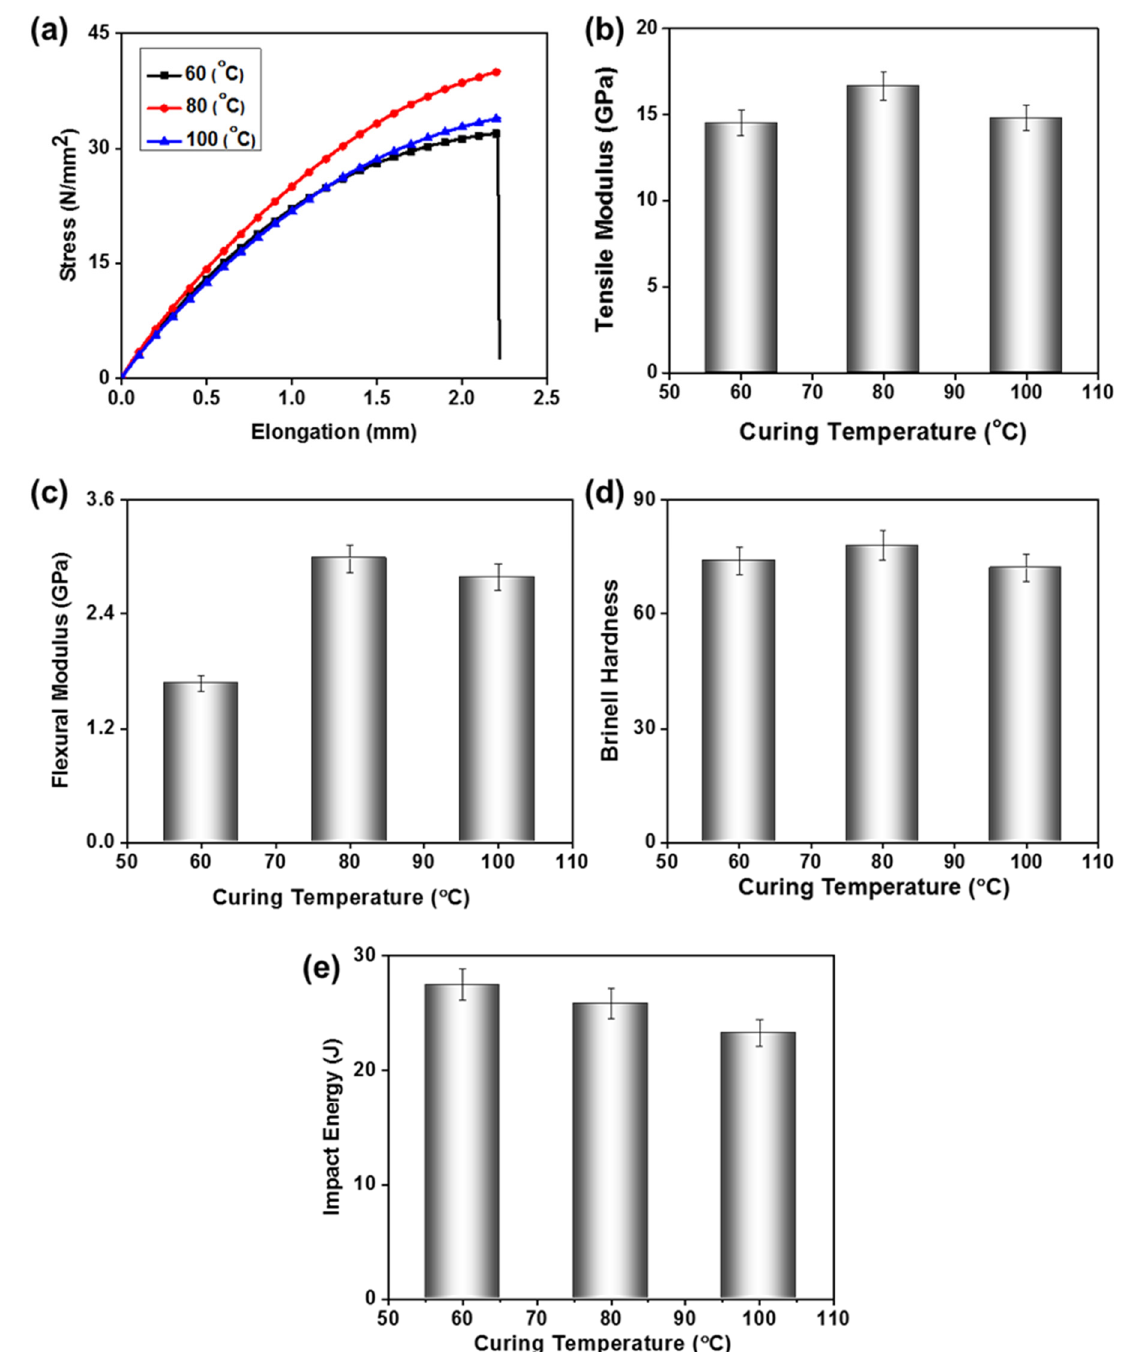
Figure 4. Effect of curing temperature on ( a ) tensile strength, ( b ) tensile modulus, ( c ) flexural strength, ( d ) Brinell hardness, and ( e ) impact resistance of TiO 2 -UP nanocomposite.